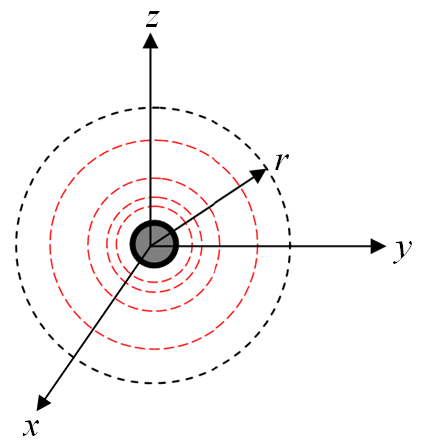
Figure 6. Coordinate system for a single